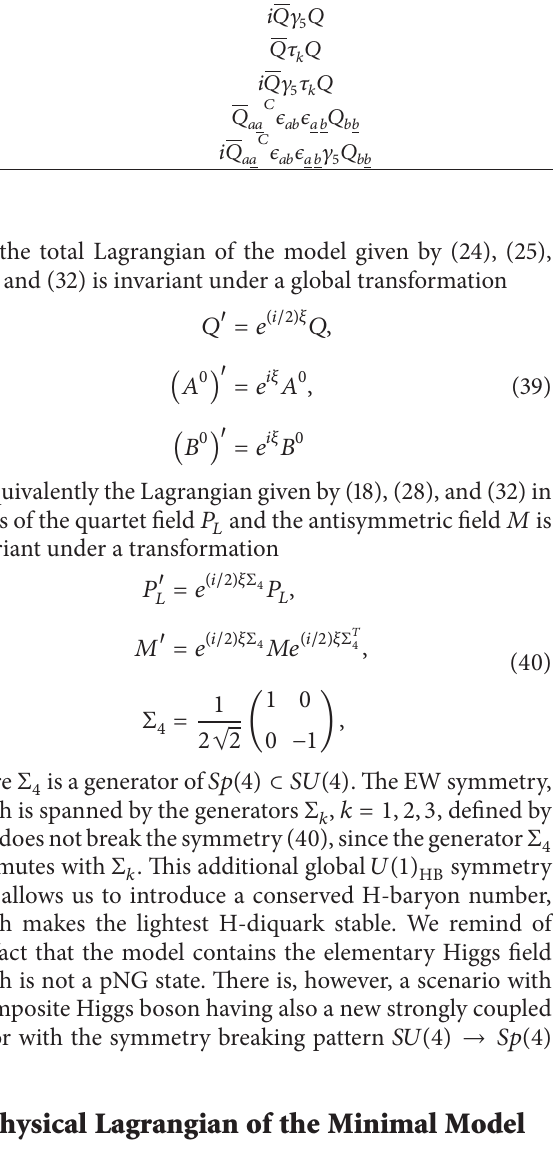
Table 1: Quantum numbers of the lightest (pseudo)scalar H-hadrons and the corresponding H-quark currents in 𝑆𝑈(2) HC model. ̃𝐵 hyper- G -parity of a state (see Section 4). is the H-baryon number. 𝑄 em is the electric charge. 𝑇 is the weak isospin. Hyperbaryons do not carry intrinsic 𝐶 - and 𝐻𝐺 -parities, since the charge conjugation reverses the sign of the H-baryon number. State H-quark